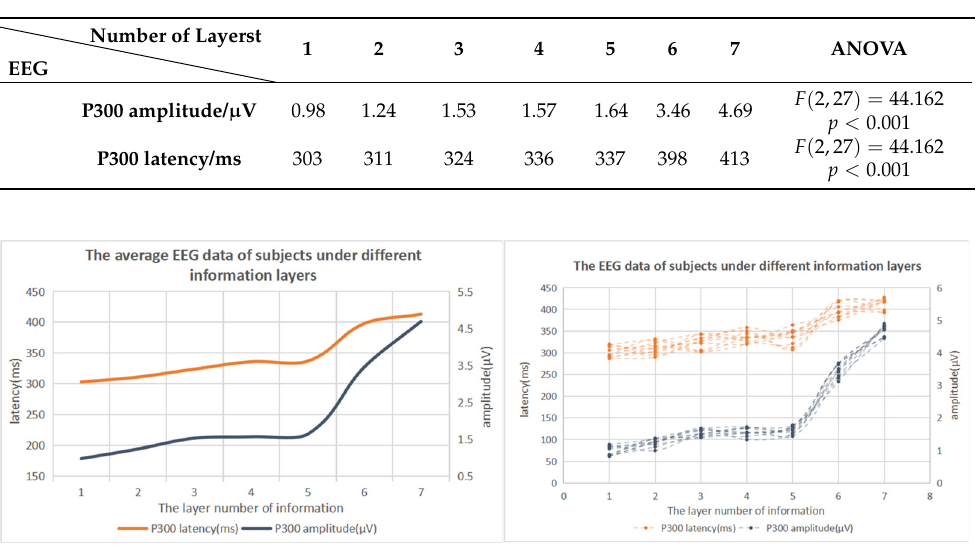
Figure 17. Variation trend of the P300 amplitude and latency of subjects under different numbers of information layers.